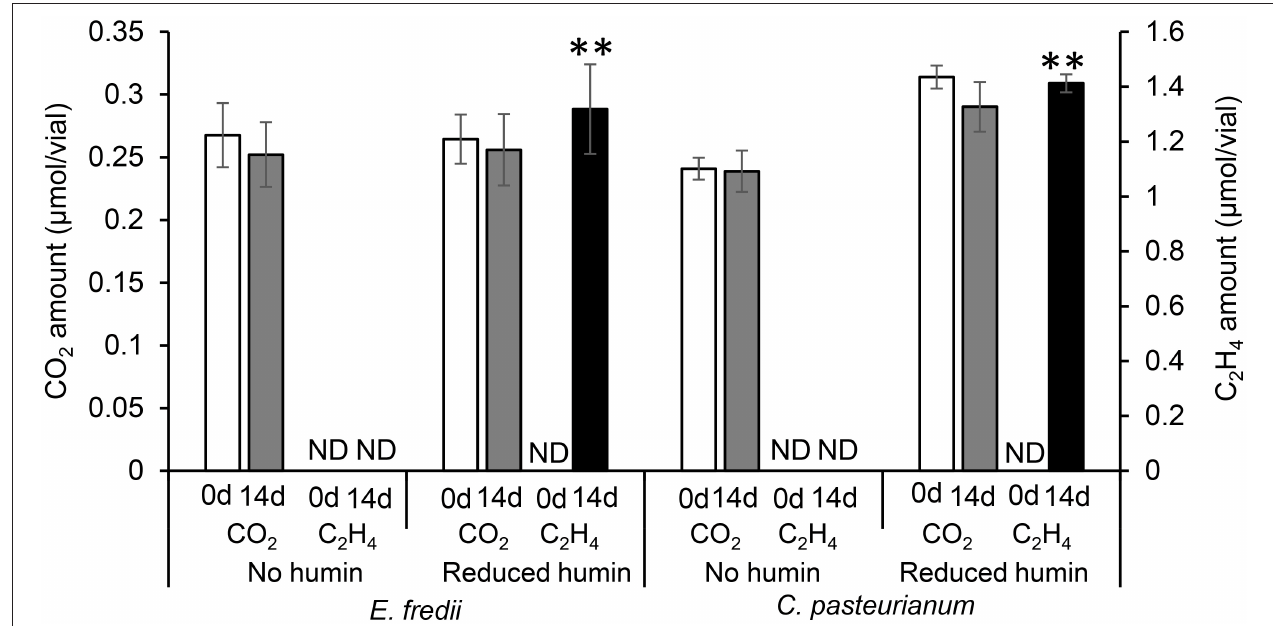
FIGURE 3 | The CO 2 amount and ARA, as the amount of ethylene produced, in the medium inoculated with washed and starved diazotrophs under the conditions with no humin and reduced humin during 14 days of incubation. Ensifer fredii was incubated under molybdenum conditions, and C. pasteurianum under vanadium conditions, respectively. No organic carbon source was added to the culture medium. Controls without inoculation showed no increase in CO 2 or ARA, regardless of the presence of the reduced humin. ND is not detected. The symbols “**” indicates significant differences at p <